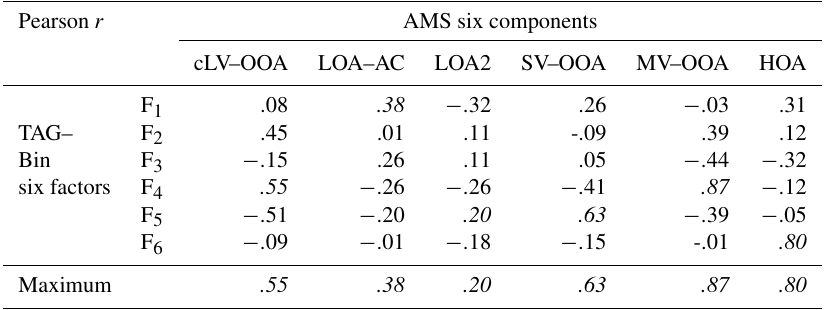
Table 2. The correlation coefficient r of factors’ time series of the PMF six-factor solution between AMS and TAG–Bin. TAG–Bin indicates the TAG binning method for source apportionment. A bin width of five scan points with retention time shift correction is used here. The italic font represents the maximum value in each